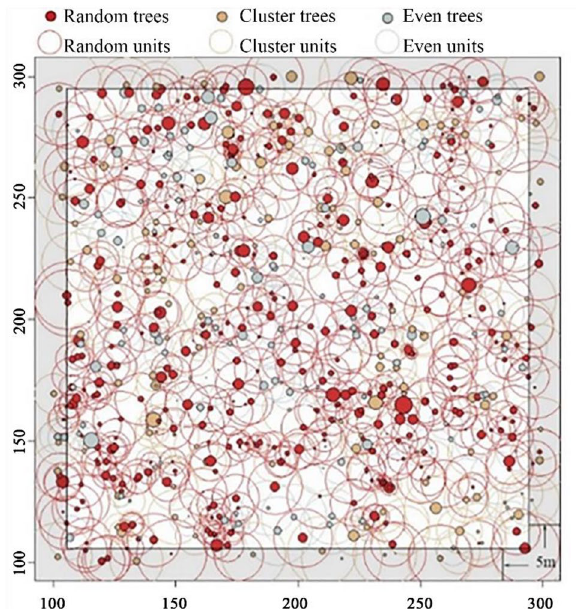
Figure 3. The structural units and buffer in Plot C4 as an example: shadow are the buffer, 5 m from each edge. Solid circles denote live trees, and their sizes are proportional to the DBH. X and Y are two perpendicular coordinate axes of the plot. All DBH is enlarged 2.5 times for viewing purposes 47 . This figure was generated by R (version 3.5.1, R Development Core Team 2020).